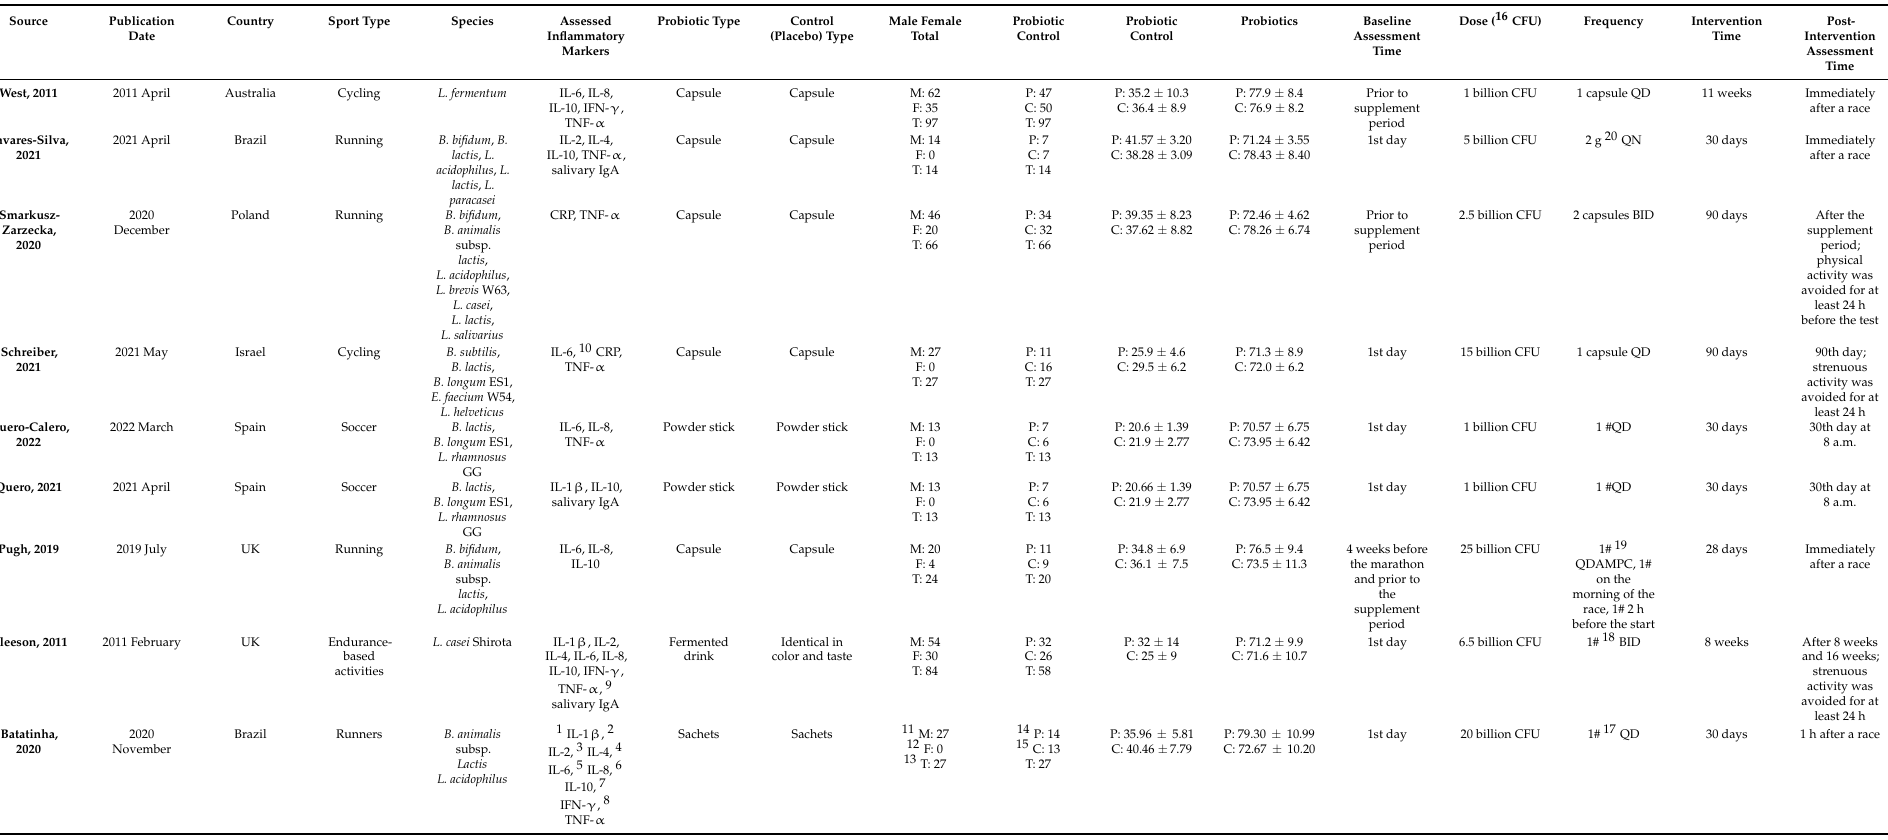
Table 1. Characteristics of the studies included in the